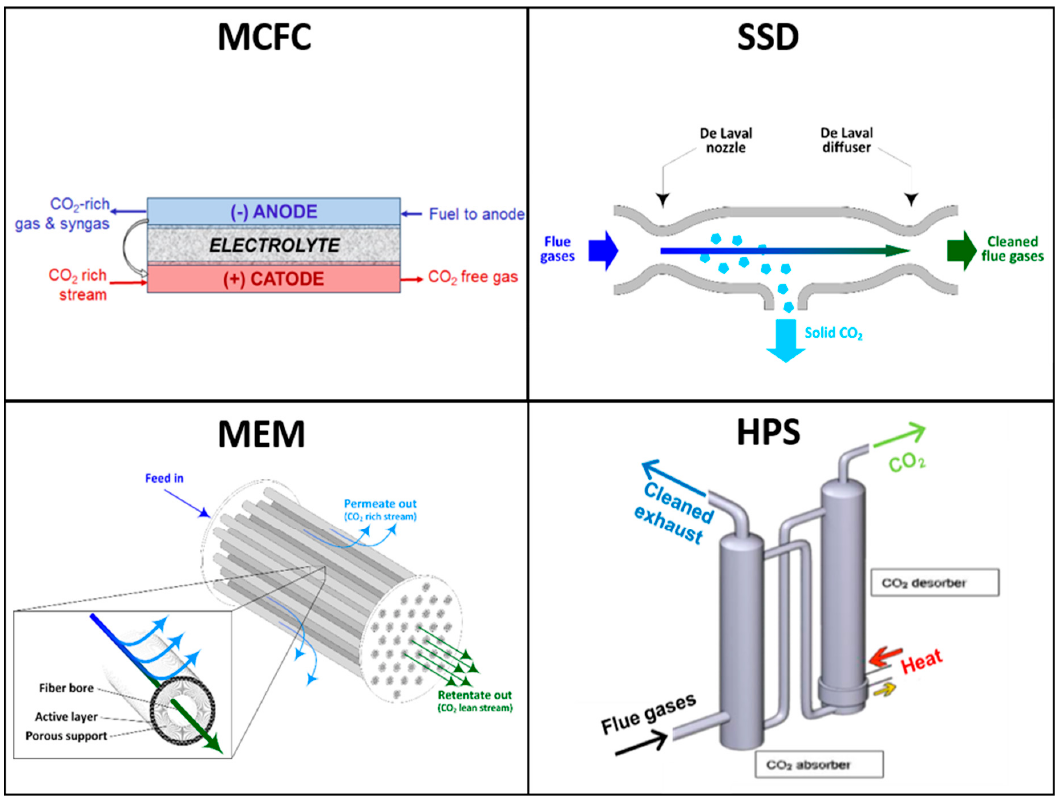
Figure 1. Conceptual representation of the CO 2 capture processes behind the four technologies evaluated in this study.